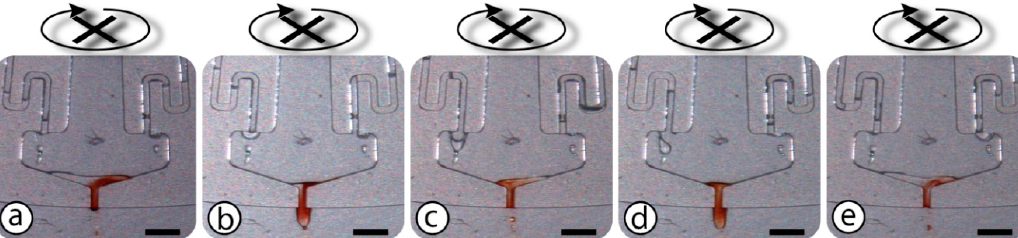
Figure 6. The image sequences show the droplet dispensing and pre-mixing process. Educts enter the siphon channels ( a ). The liquids are alternatingly issued into the common chamber with the nozzle outlet where the educts are pre-mixed before being dispensed through the nozzle into the mixing chamber ( b – e ). Images shown are acquired in time-steps of approximately 0.6 s.